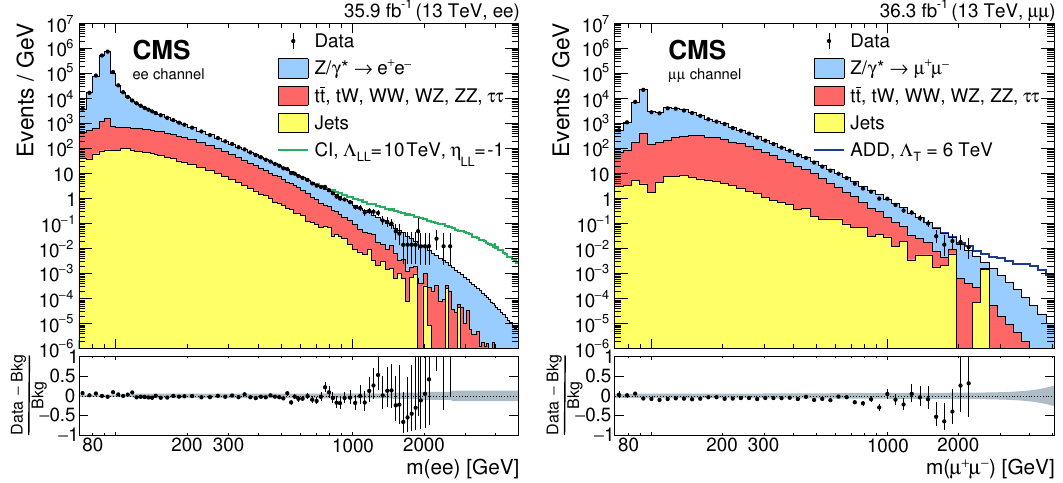
Figure 1 . Electron (left) and muon (right) pair invariant mass spectra for the combined barrel- barrel and barrel-endcap event categories. Example model predictions are given for CI (left) and ADD (right). The lower panel shows the relative di(cid:11)erence between the data and predicted back- ground. The gray band gives the fractional uncertainty (statistical and systematic) in the